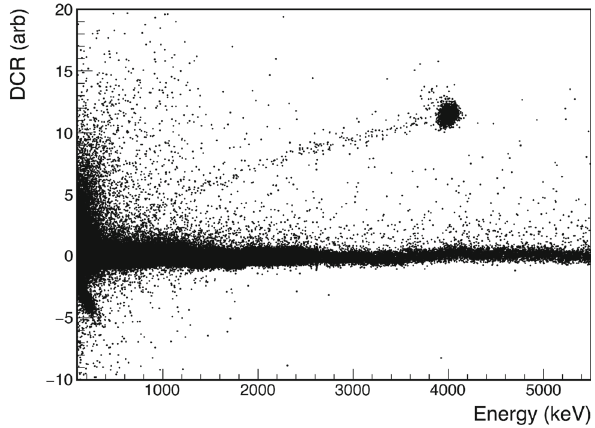
Fig. 7 The DCR and energy distribution measured with the α source incident at r = 18 . 0mm. The tail of events degraded in energy and DCR is thought to be due to α ’s that deposit their energy at shallower depths, as discussed in Sect. 3.2. Events with low values of DCR are caused by